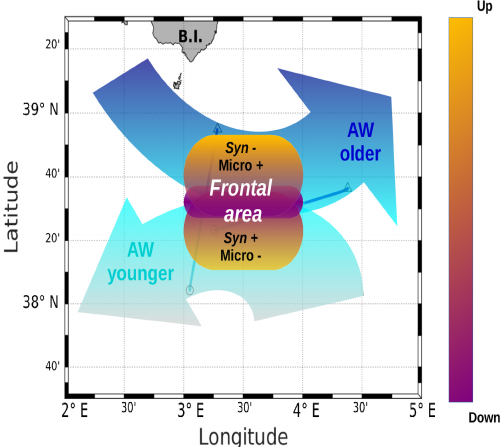
Figure 10. A schematic view of the of PROTEVSMED-SWOT re- sults in the surface layer. A narrow frontal area, characterized by the change in direction of the horizontal current and by opposite vertical movements, corresponds to a rapid shift in hydrological properties and biological content of the two water masses separated by the front. For simplicity’s sake, only two groups of phytoplank- ton, Synechococcus (Syn) and microphytoplankton (Micro), are in- dicated, but their contrasted abundances are also representative of those of other phytoplankton